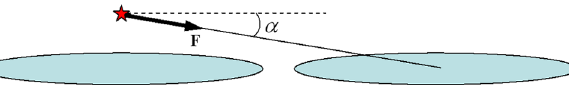
FIG. 12. Kick from a flat beam separated horizontally.